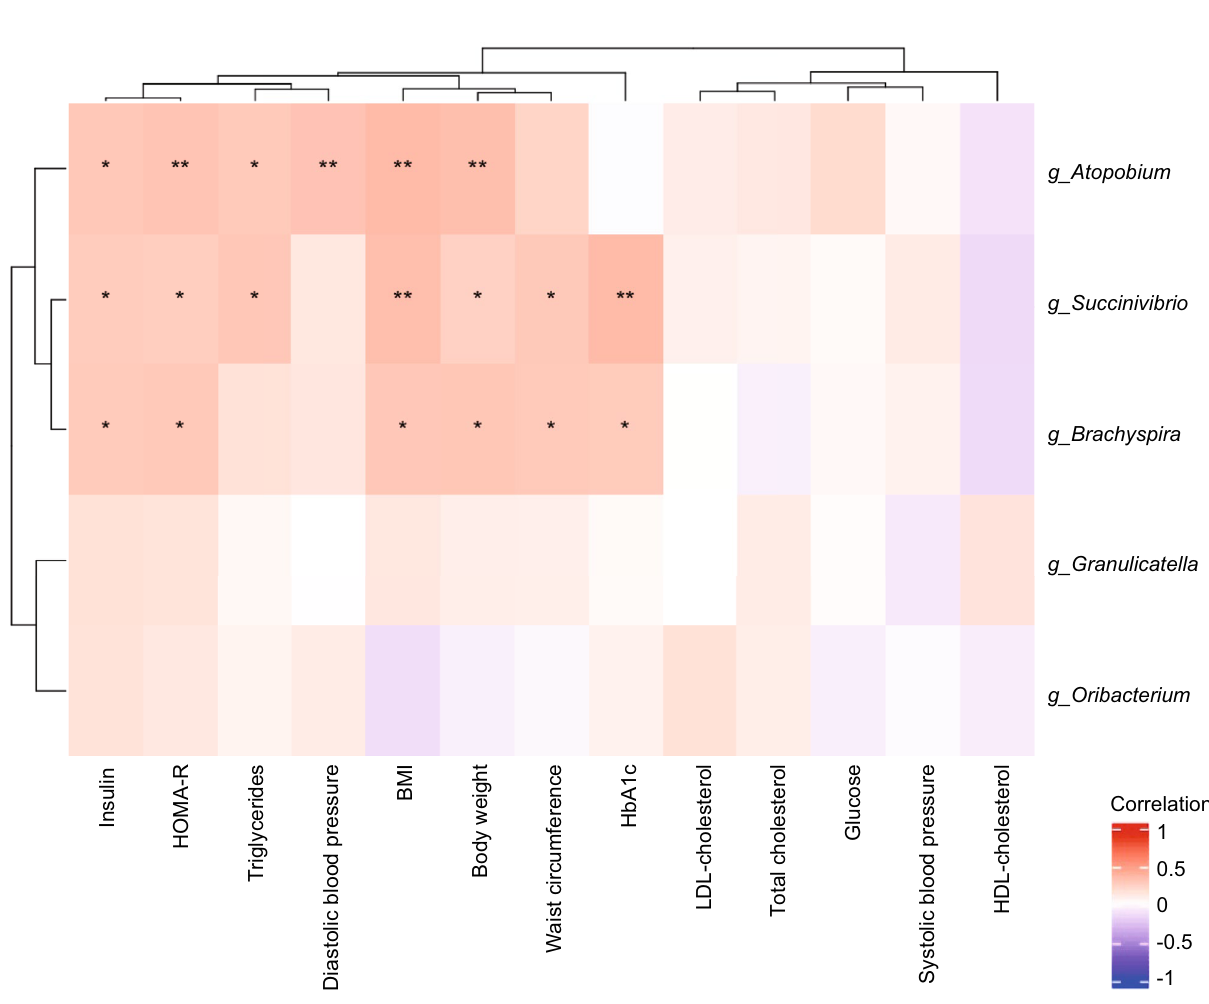
Figure 4. Spearman’s correlation heat map showing significant correlations of gut microbiota at the genus level and selected parameters in subjects with abdominal obesity (n = 75). Significant correlations are shown as red (positive) or blue (negative). Graphics were made using the R-package (version 4.0.3). * p < 0.05; ** p <